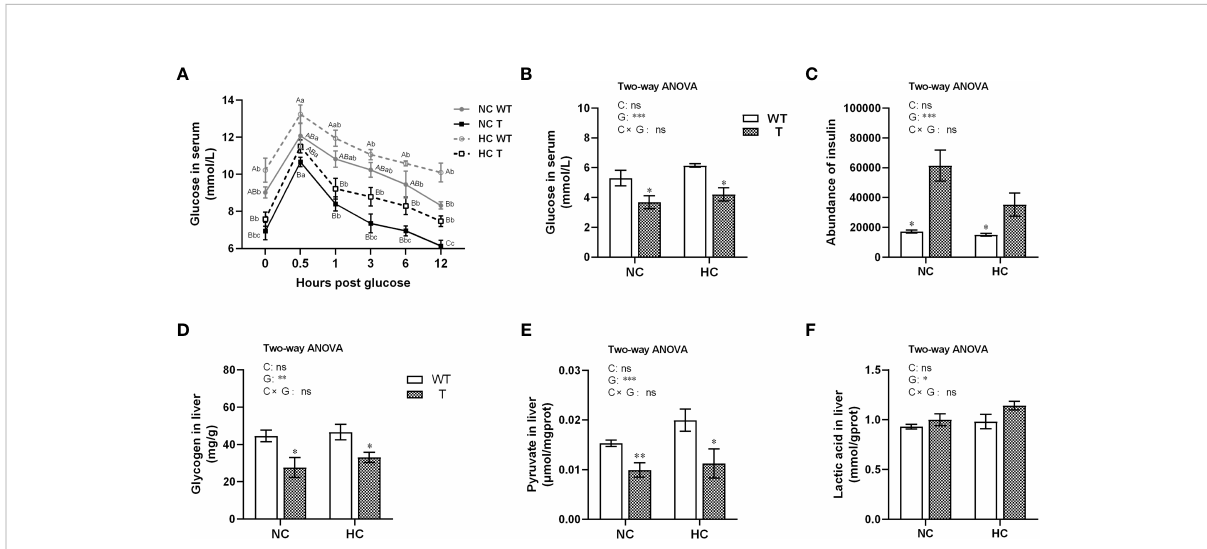
FIGURE 5 Glucose utilization in T and WT common carp fed a diet with normal or high-carbohydrate content. (A) Serum glucose levels in intraperitoneal glucose tolerance test (GTT) (n = 5). (B, C) Serum glucose (n = 6) and insulin (n = 3) levels. (D-F) Glycogen, pyruvate, and lactic acid contents in the liver (n = 6). In the GTT, different lowercase letters indicate signi fi cant differences ( P < 0.05) at different time points within each group, whereas different uppercase letters indicate signi fi cant differences ( P < 0.05) among different groups at the same sampling time point. * and ** indicate a signi fi cant difference ( P < 0.05 and P < 0.01, respectively) in different strains at same dietary starch content. In two-way ANOVA, C, carbohydrate; G, GH. * P < 0.05, ** P < 0.01, *** P < 0.001, ns, indicates no signi fi